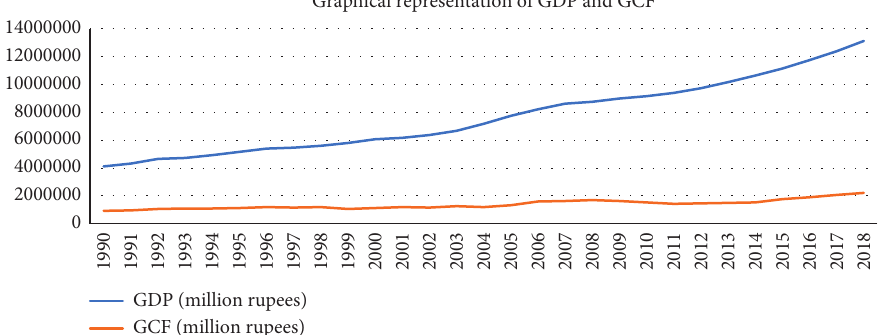
Figure 3: A graphical representation showing a comparison between GDP and GCF data from 1990 to 2018. The X -axis shows the number of years, while the Y -axis shows values in millions of Pakistani rupees.